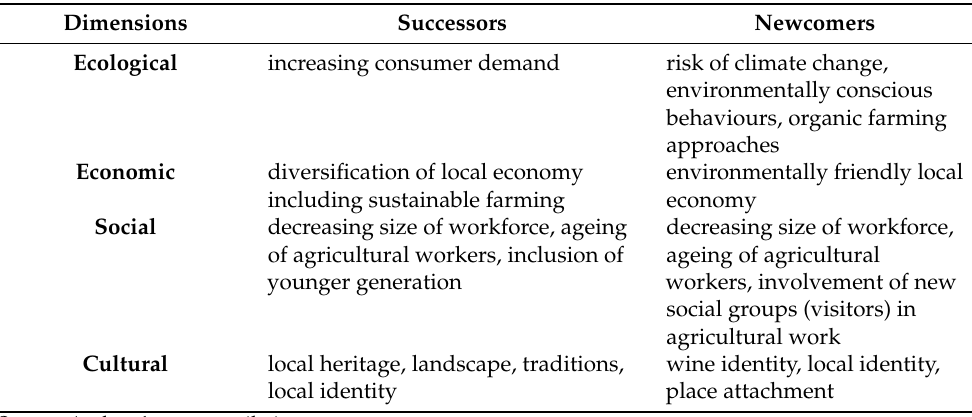
environmentally conscious behaviours, organic farming approaches environmentally friendly local economy decreasing size of workforce, ageing of agricultural workers, involvement of new social groups (visitors) in agricultural work wine identity, local identity, place